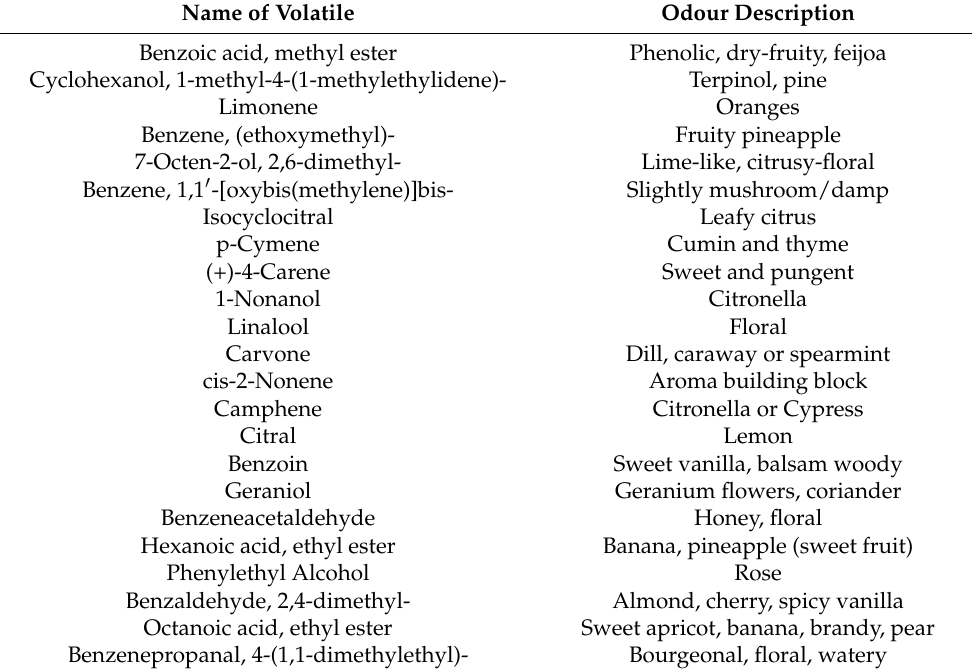
Table A1. Putatively identified aroma compounds that were significantly altered between sound treatments and